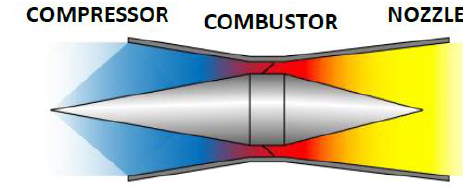
Figure 2. Scramjet engine schematic.